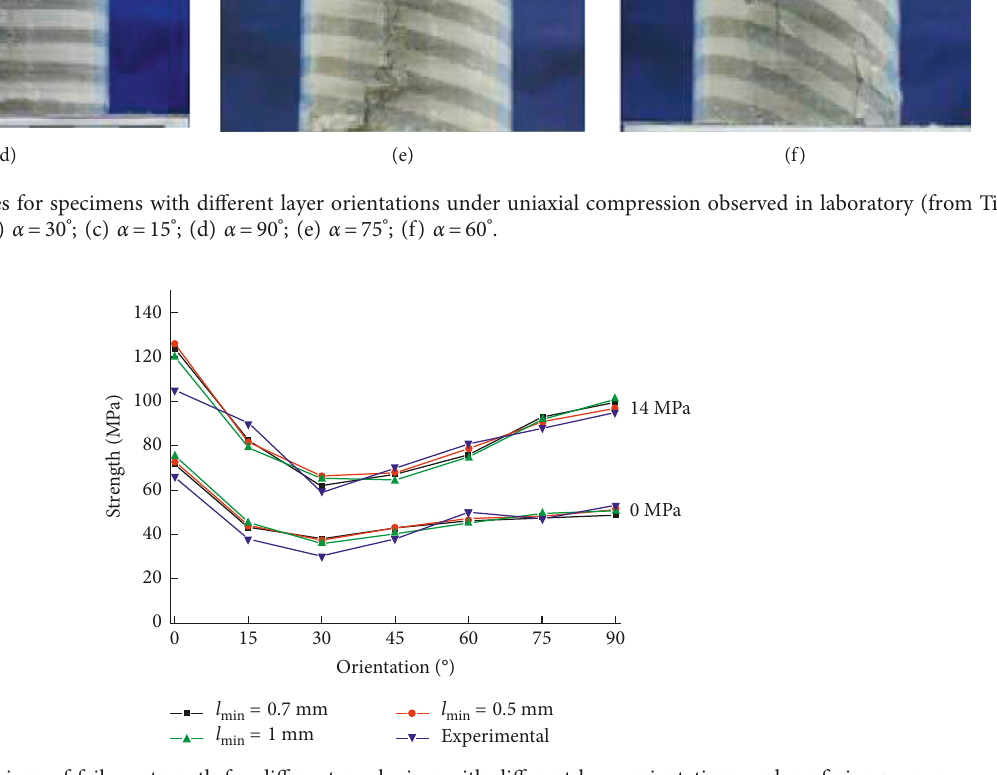
Figure 20: Comparison of failure strength for different mesh sizes with different layer orientations and confining